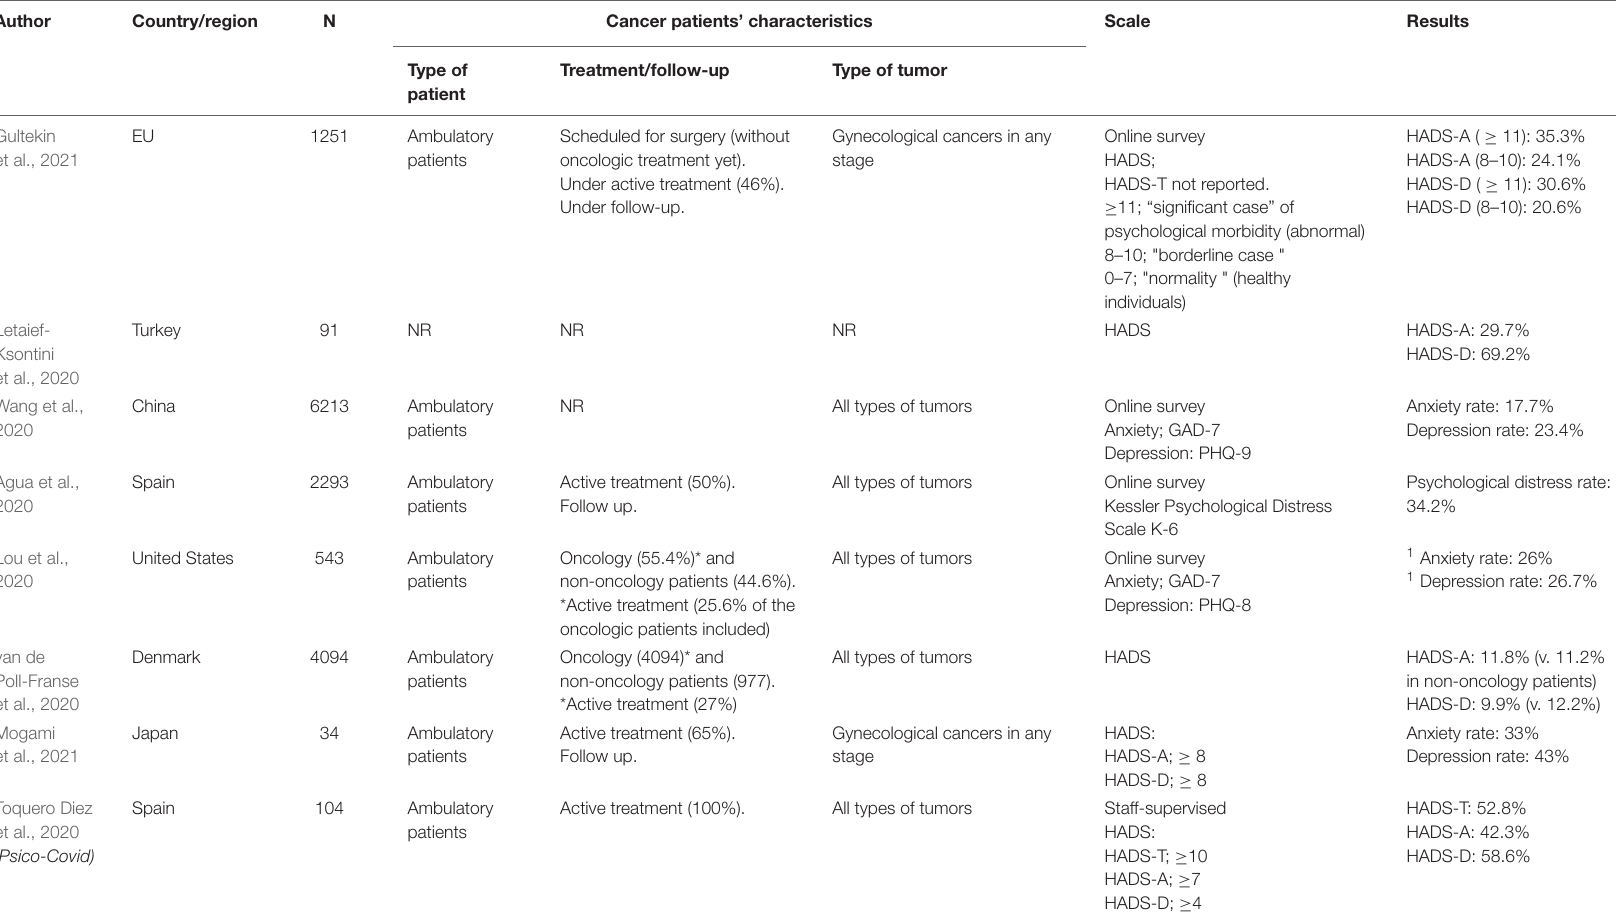
TABLE 5 | Main studies evaluating emotional impact and COVID-19 in oncology patients using validated scales to measure psychopathological symptomatology compared with our